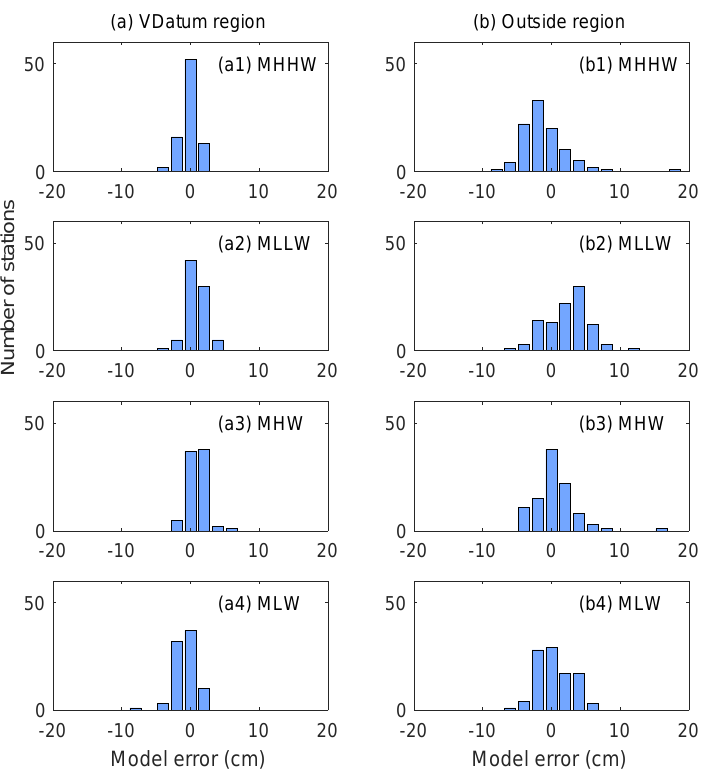
Figure 7. Histograms of model errors for tide stations ( a ) in and ( b ) outside the VDatum region.